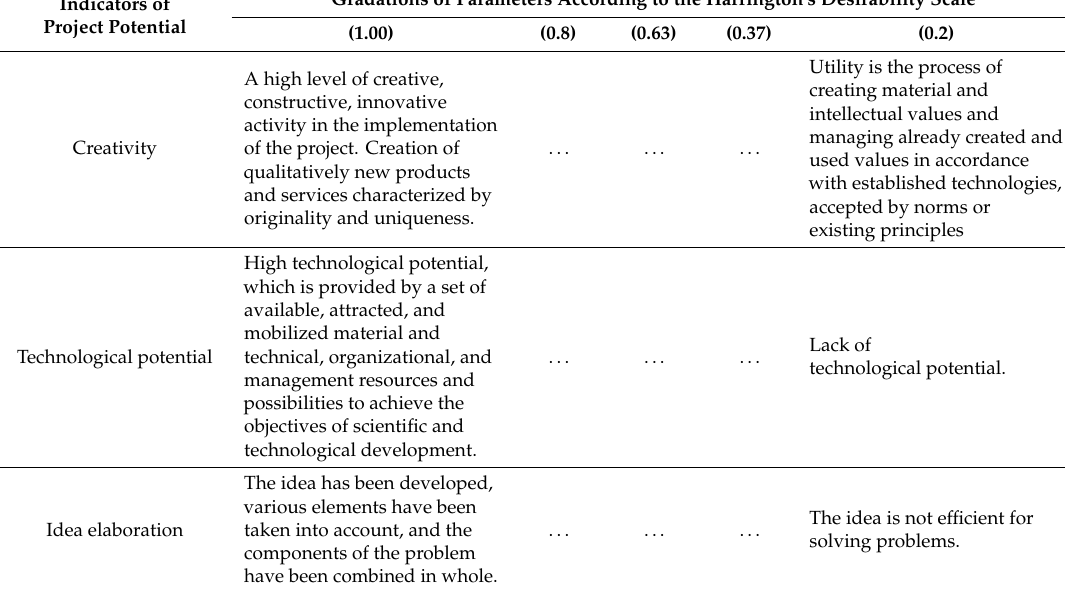
Table 1. Evaluation map of the analyzed enlarged parameters of industrial ecosystem state (compiled by the